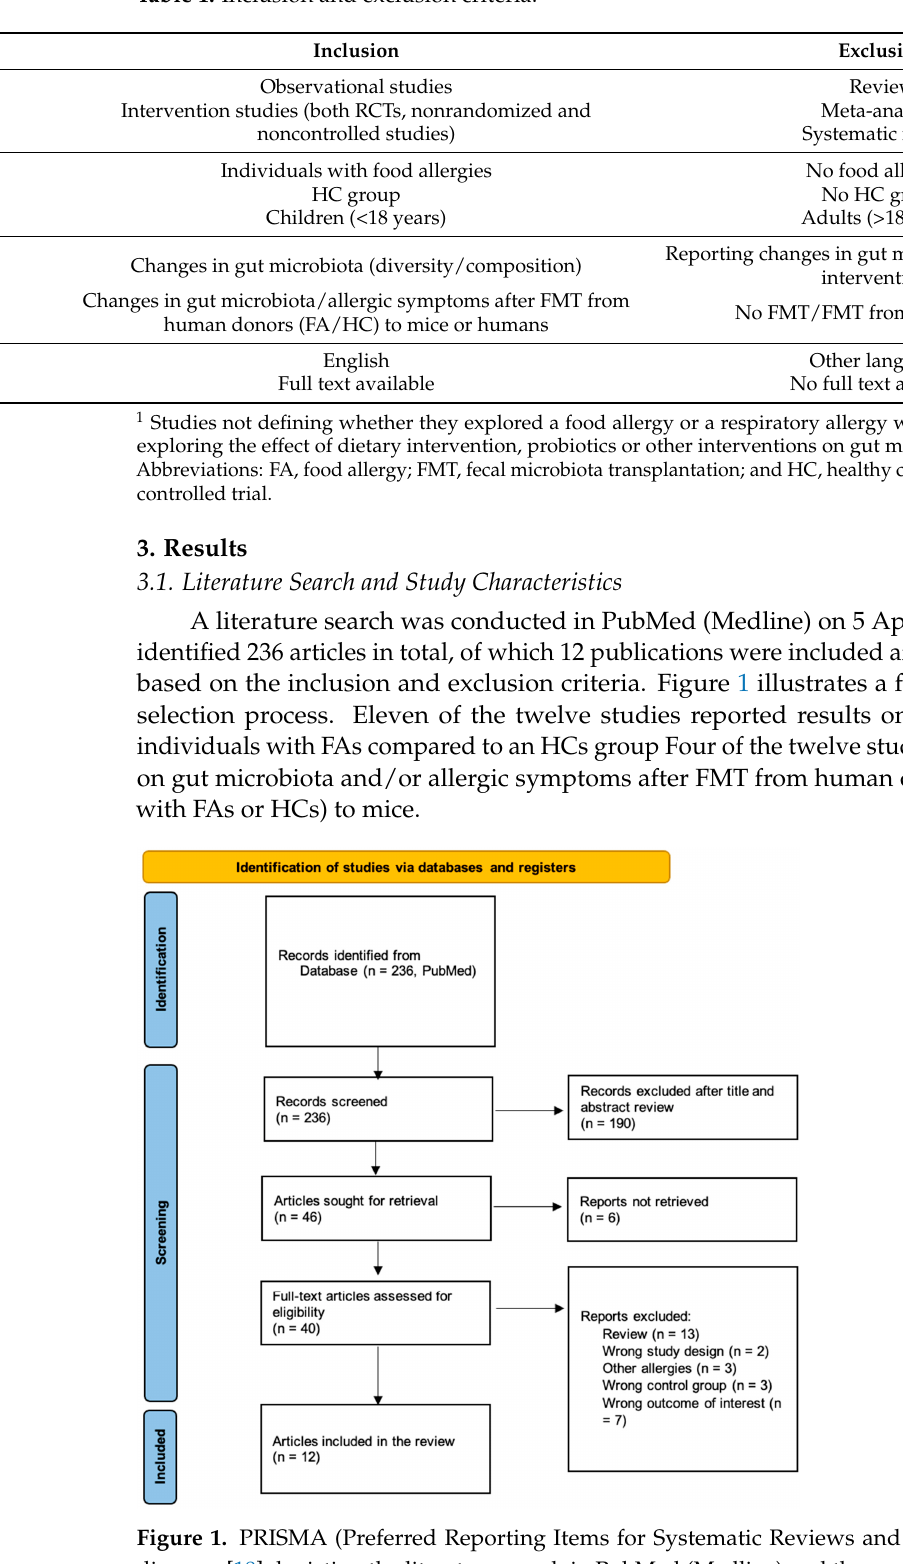
Table 1. Inclusion and exclusion criteria.